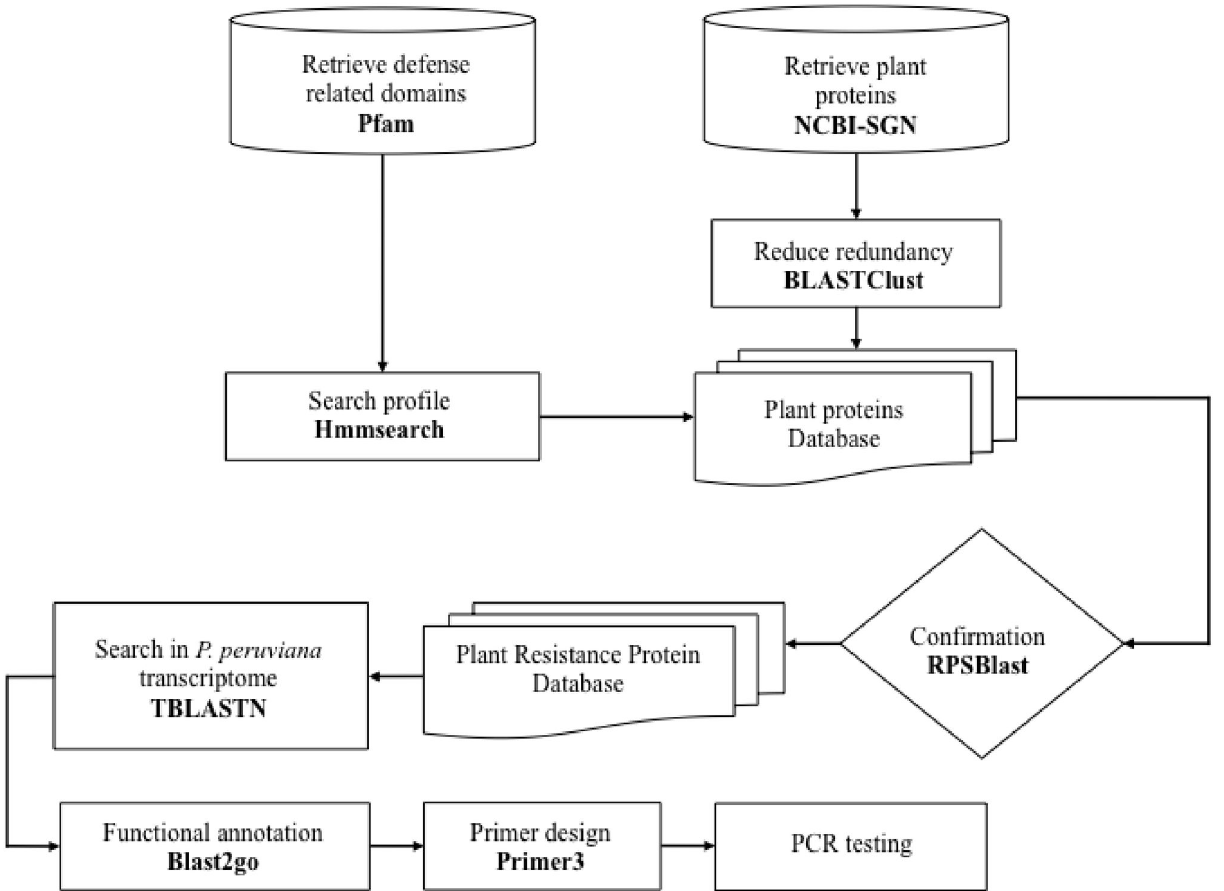
Figure 1. Pipeline used to search for resistance related domains in Physalis peruviana foliar transcripts. doi: